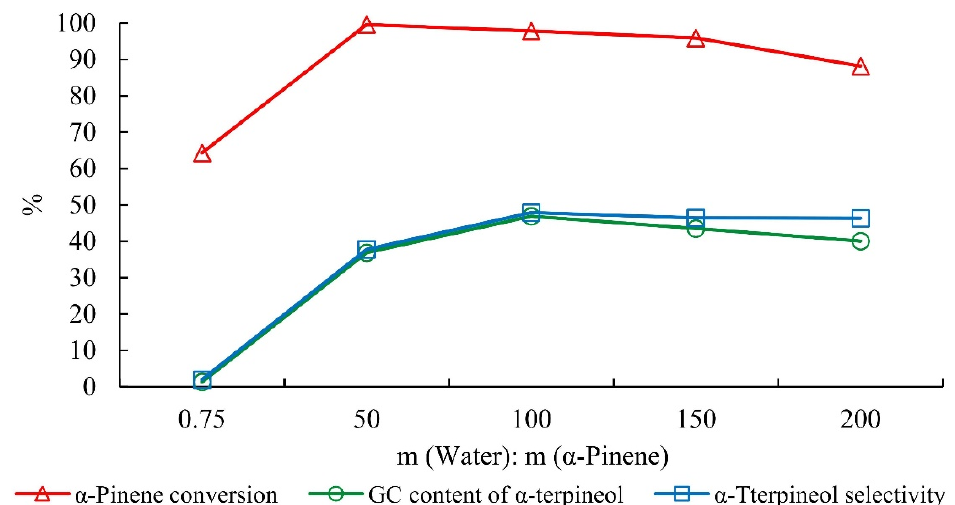
Figure 6. Effect of water dosage on the hydration of alpha-pinene. Note: The mass ratio of alpha- pinene, acetic acid, citric acid, and phosphoric acid was 1:2.5:0.1:0.05 for 15 h.